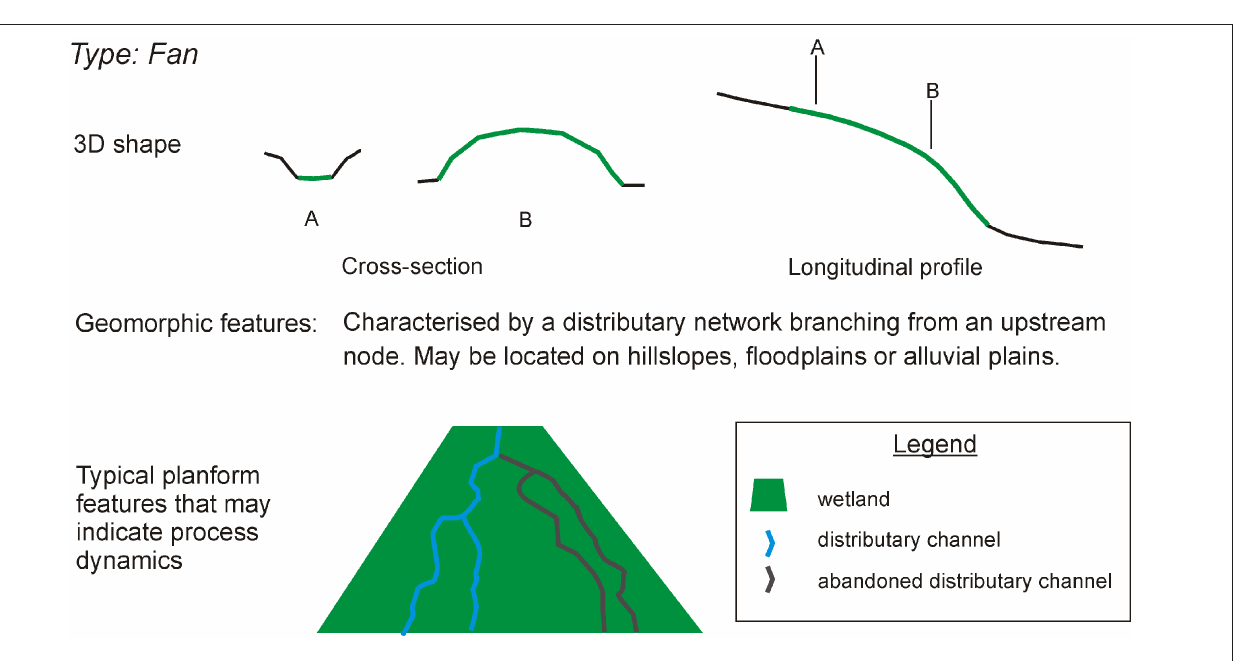
FIGURE 7 | Schematic shape and geomorphic features that are used to classify a fan type wetland, followed by typical planform features that may or may not